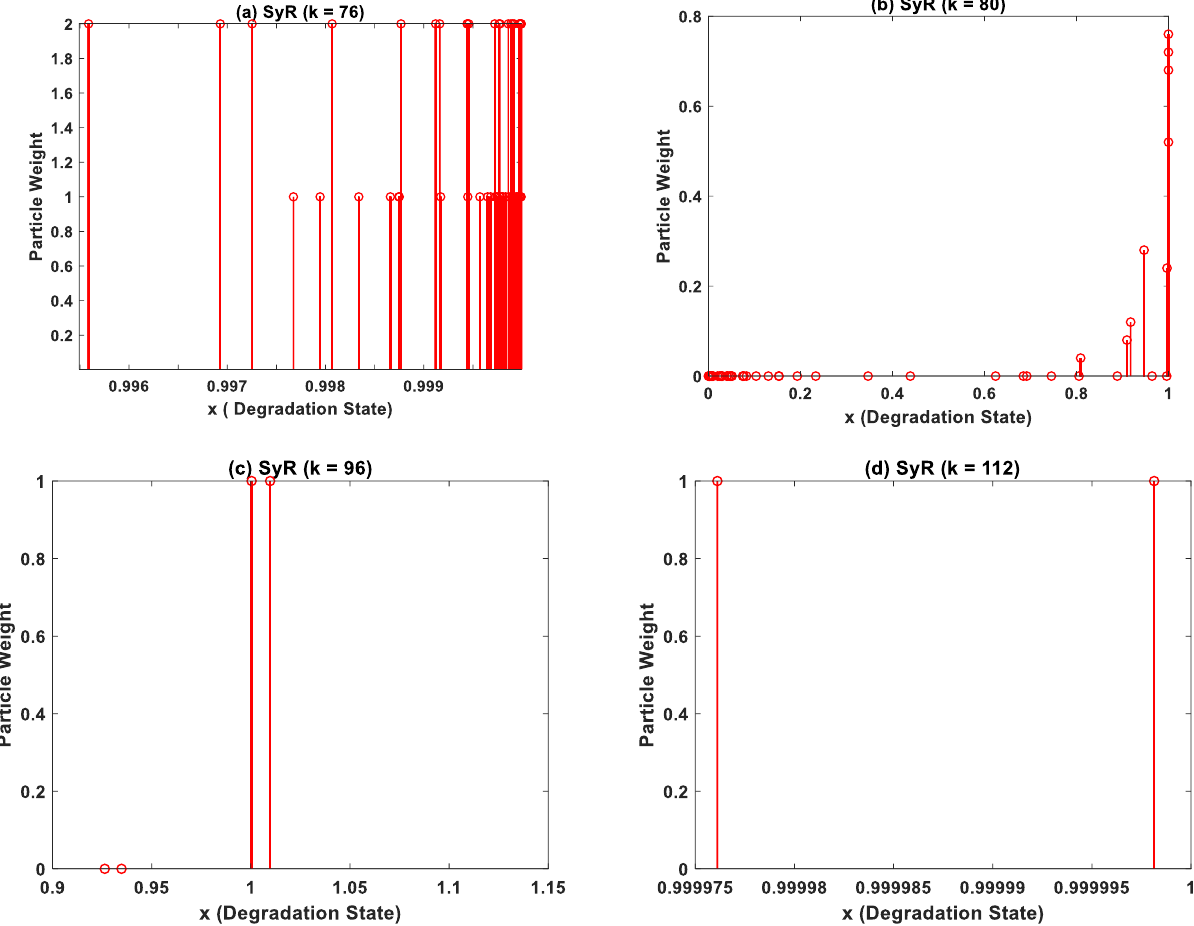
Figure 9. The particle weight distribution obtained during execution of particle filter algorithm using systematic resampling (SyR) at the ( a ) 76th ( b ) 80th ( c ) 96th, and ( d ) 112th time step. The particle weight distribution in ( d ) depict particle impoverishment despite using adopting robust resampling strategies.